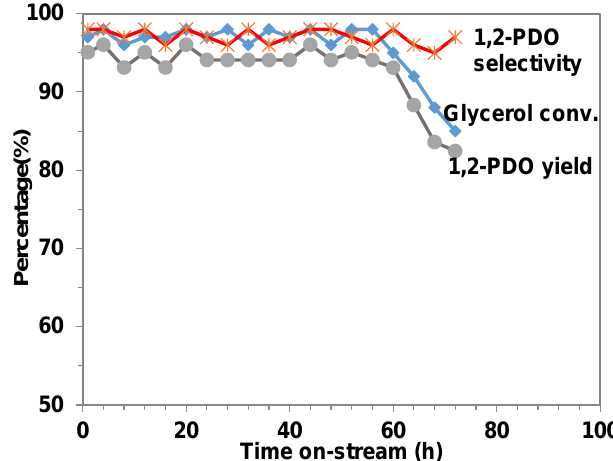
Figure 9. Long term stability of 5Cu-1B/Al 2 O 3 catalyst in glycerol hydrogenolysis conducted at 250 °C, 6 MPa H 2 flow and 0.1 h −1 .